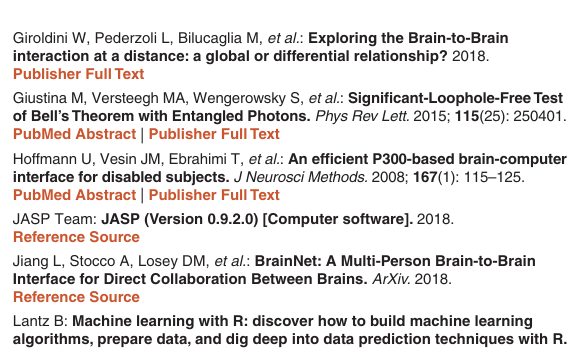
Both datasets are available on Figshare: Brain-to-Brain inter- action at a distance: a global or differential